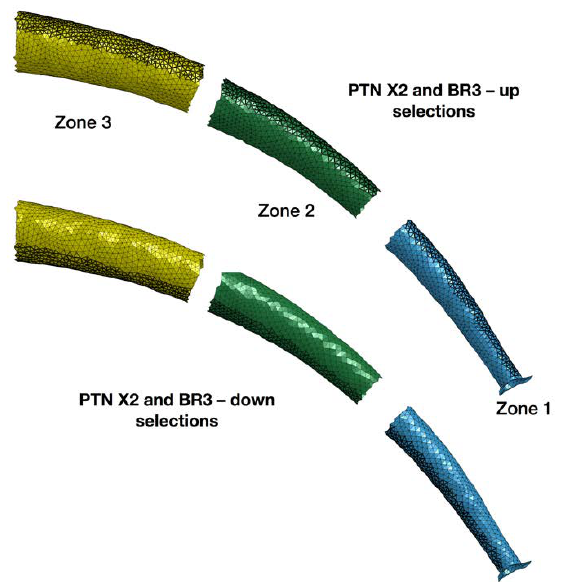
Figure 2. The division in different zones of the virtually replicated canals (Zone 1, Zone 2 and Zone 3). The three zones of 2 mm length are equally distributed from the apical third of the root canal. Top (root canal portion outside the curvature) and Down (root canal portion inside the curvature) areas of the simulated root canals are shown in black.